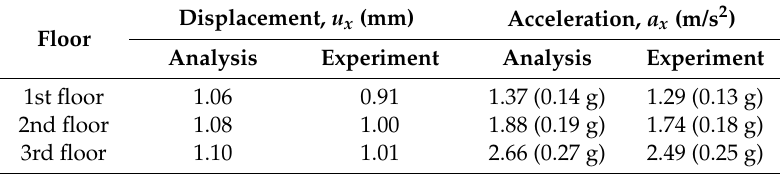
Table 7. Absolute maximum seismic responses at point A due to the low-intensity ground